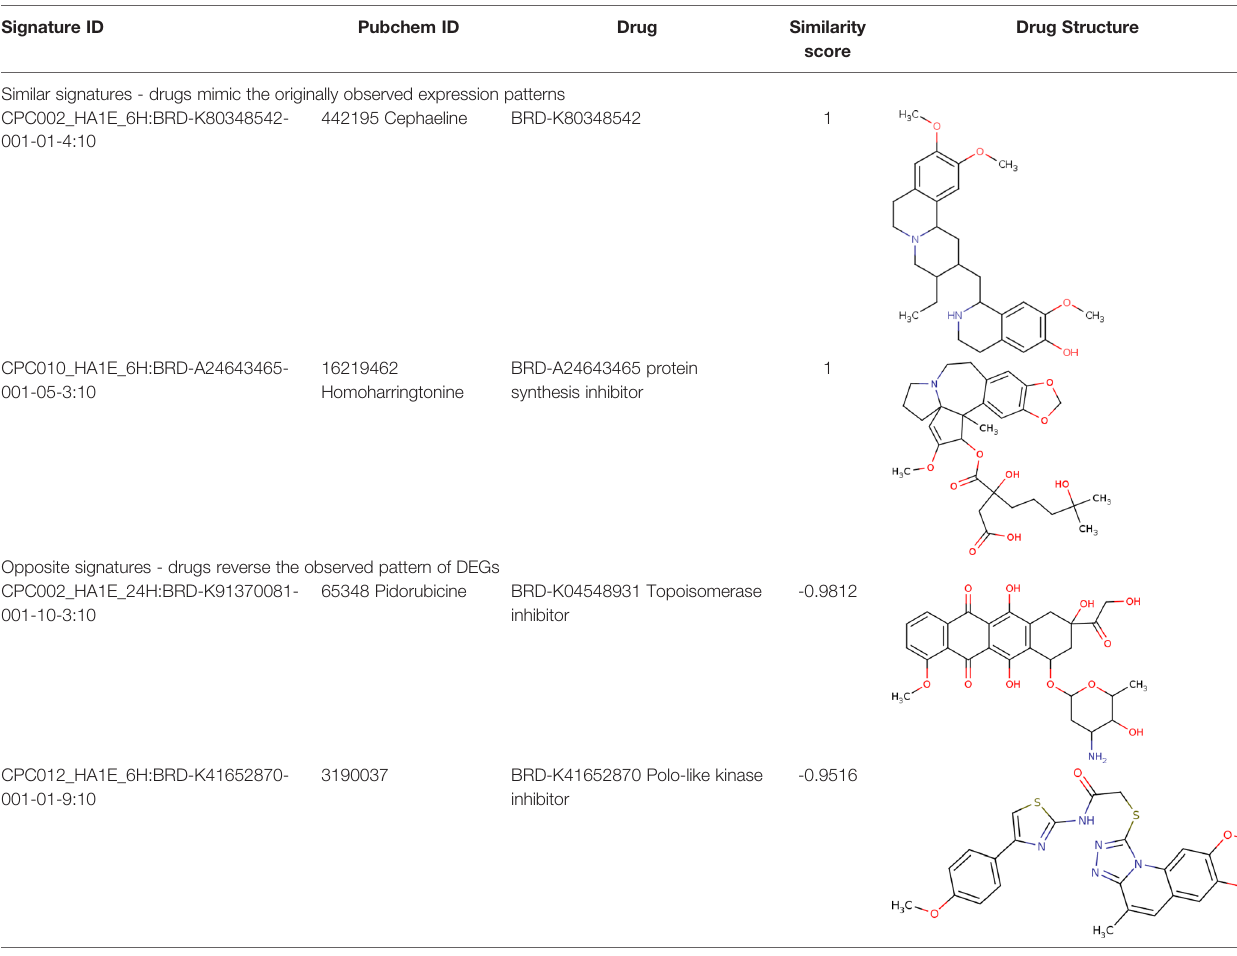
TABLE 3 | Drug perturbation analysis of the overlapped